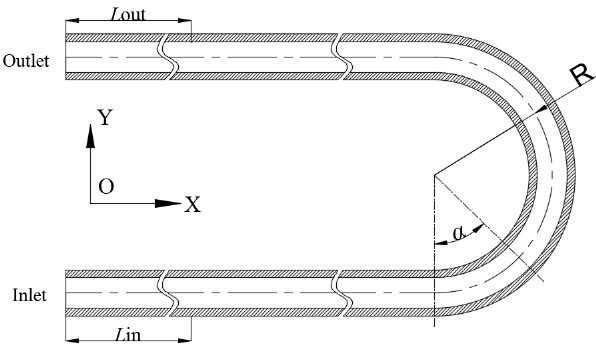
Figure 1. The computational model of a U ‐